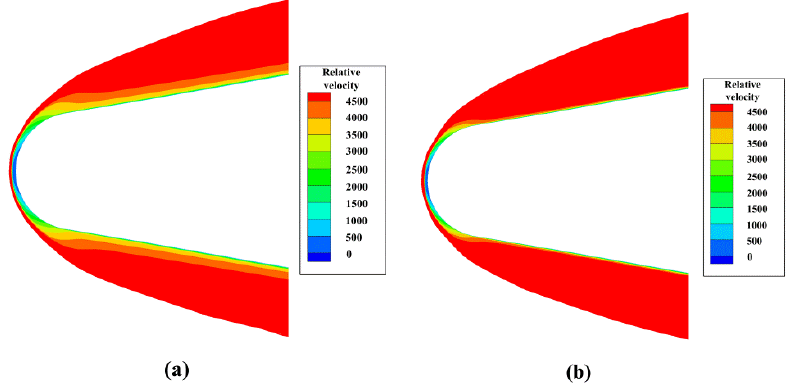
Figure 6. The velocity field distribution in scenes 4 and 5. ( a ) Velocity is Mach 20. ( b ) Velocity is Mach 25.